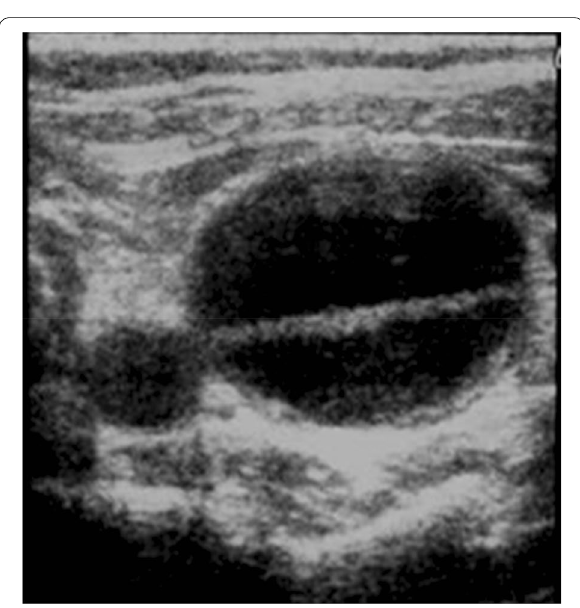
Fig. 5 Blunt trauma to the neck. Transverse view of the left side of the neck showing the carotid artery and a dilated jugular vein with with detachment of the